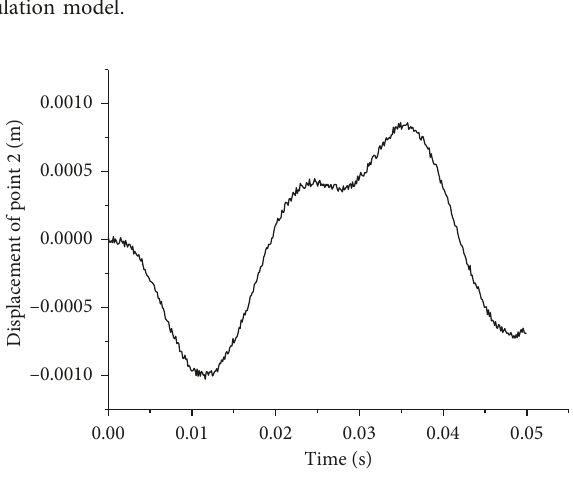
Figure 4: Displacement response of point 2 by F